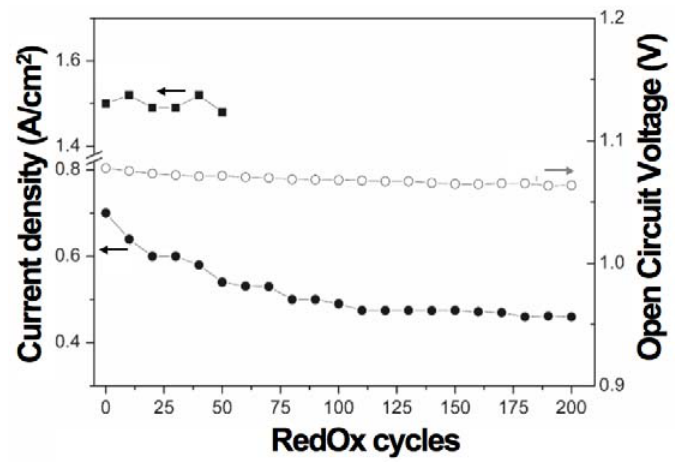
Figure 34. Open circuit voltage (open circle), current density at 0.7 V (10 min in H 10 min in air) at 750 °C (closed circles), and current density at 800°C applying 2 h in H and 10 min in air (closed square), all as a function of the number of RedOx cycles with SYT ceramic anodes